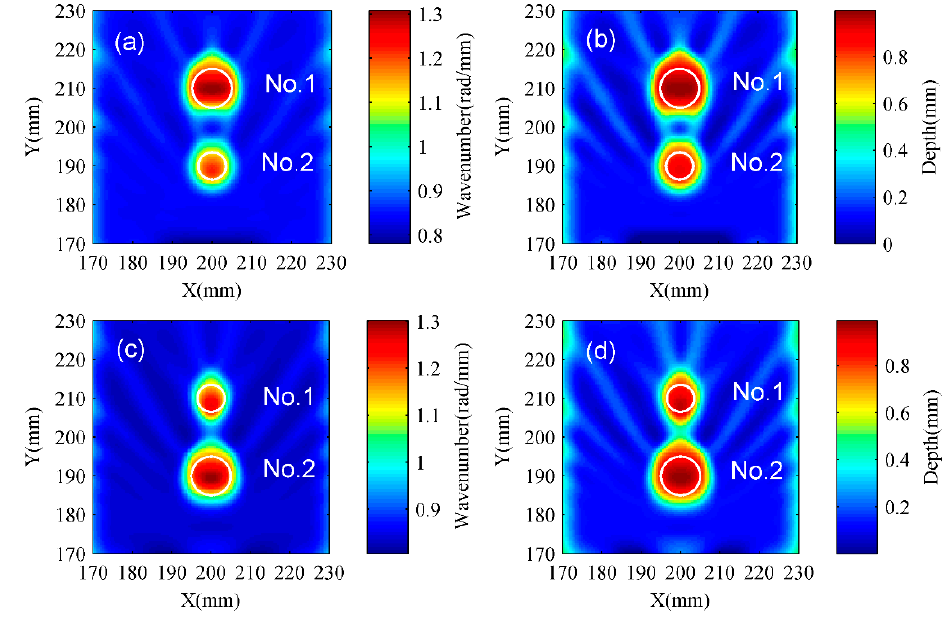
Figure 13. Simulation results of Case 8 and Case 9. ( a ) Wavenumber distribution of Case 8; ( b ) depth distribution of Case 8; ( c ) wavenumber distribution of Case 9; ( d ) depth distribution of Case 9. The white circle represents the actual location of the damage. The actual depth of the defect is 1 mm.